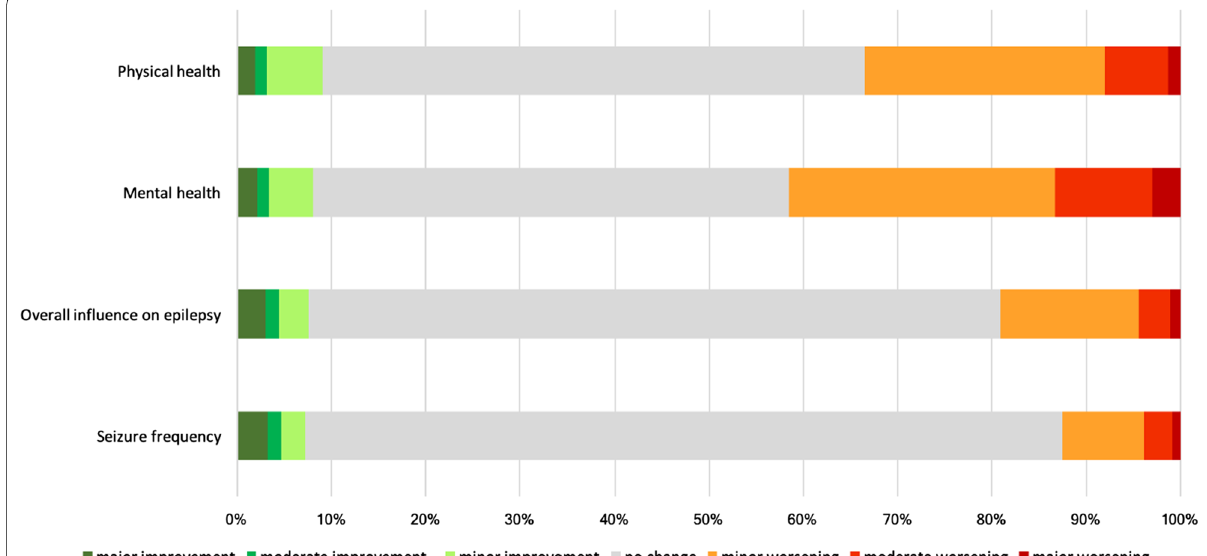
Fig. 1 Effect of the first wave of the COVID‑19 pandemic on physical health, mental health, the overall course of epilepsy, and seizure frequency, as reported on a 7‑point Likert